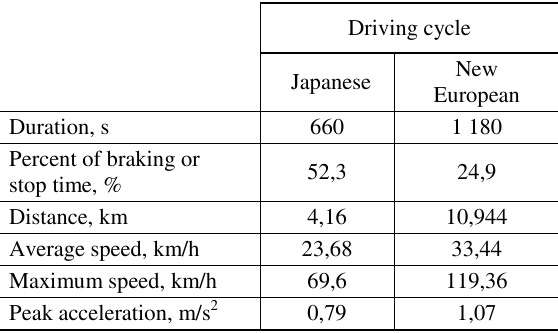
Fig 17. Power characteristics of parallel hybrid drive, Japanese driving cycle